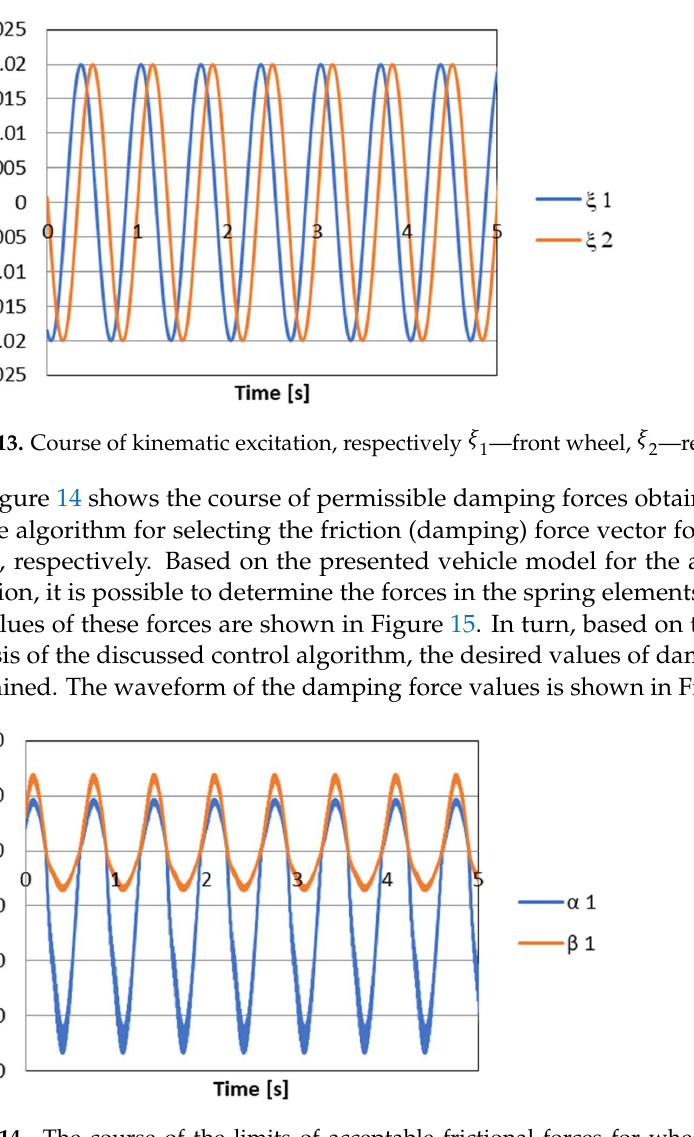
Figure 14. The course of the limits of acceptable frictional forces for wheel 1 (as compared to Figure 12).